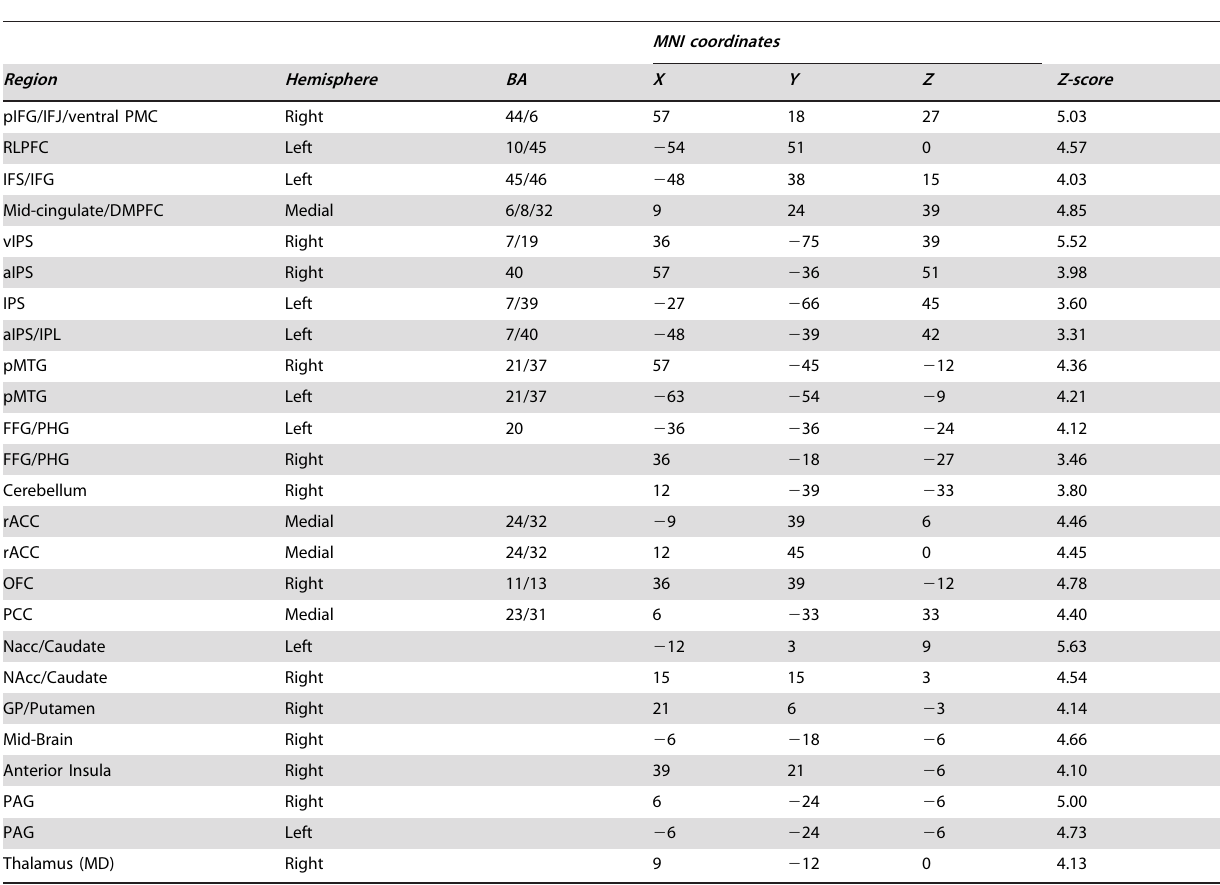
Table 2. Regions exhibiting significant functional connectivity with the